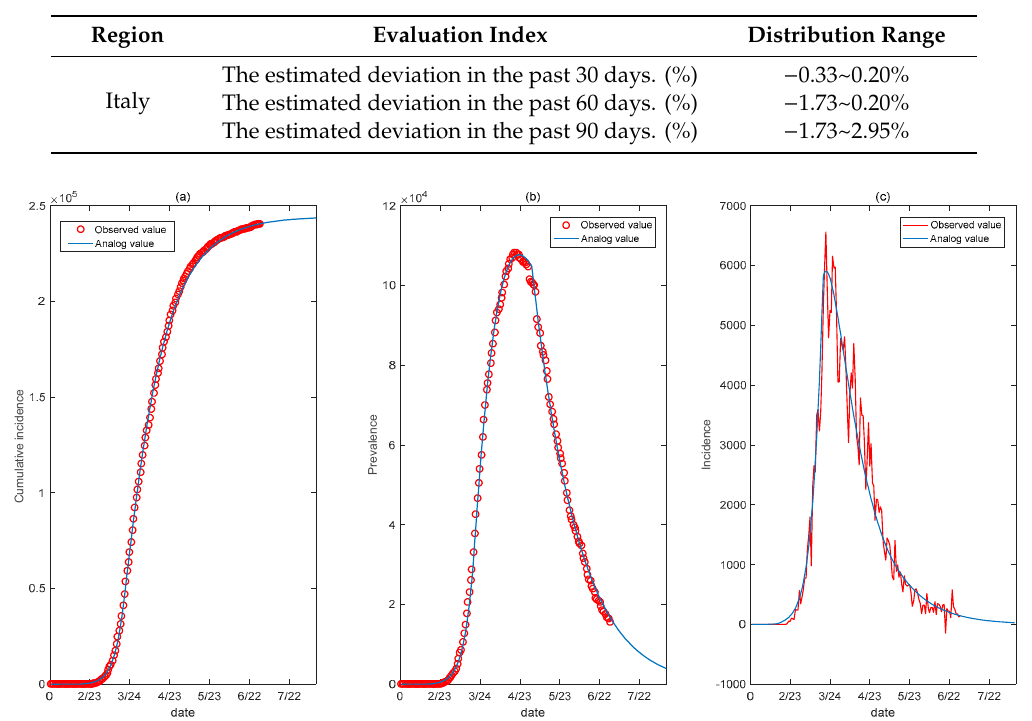
Table 2. Model fitting e ff ect.